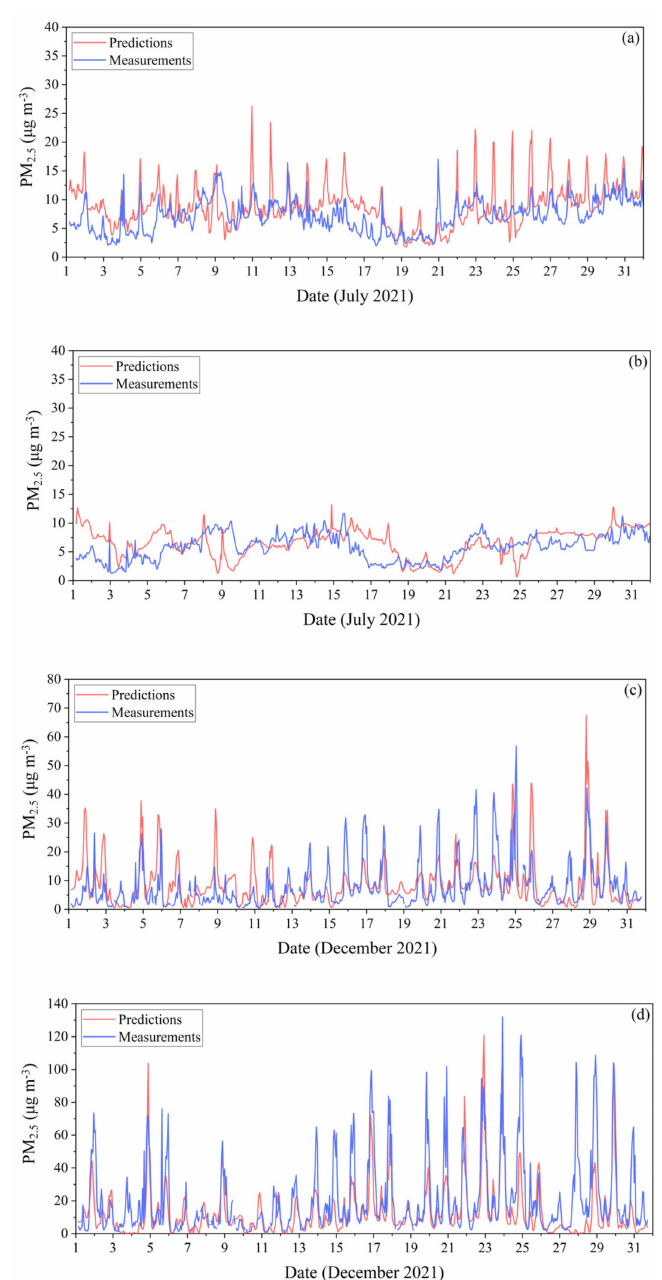
Figure 13. Predicted and measured time series for PM 2.5 in ( a ) Georgiou Sq. and ( b ) Platani during July 2021 and in ( c ) Agia and ( d ) Kypseli during December 2021. Different scales are